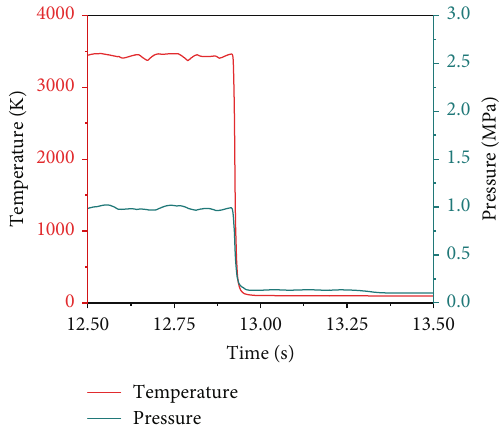
Figure 15: Shutdown process in variable thrust